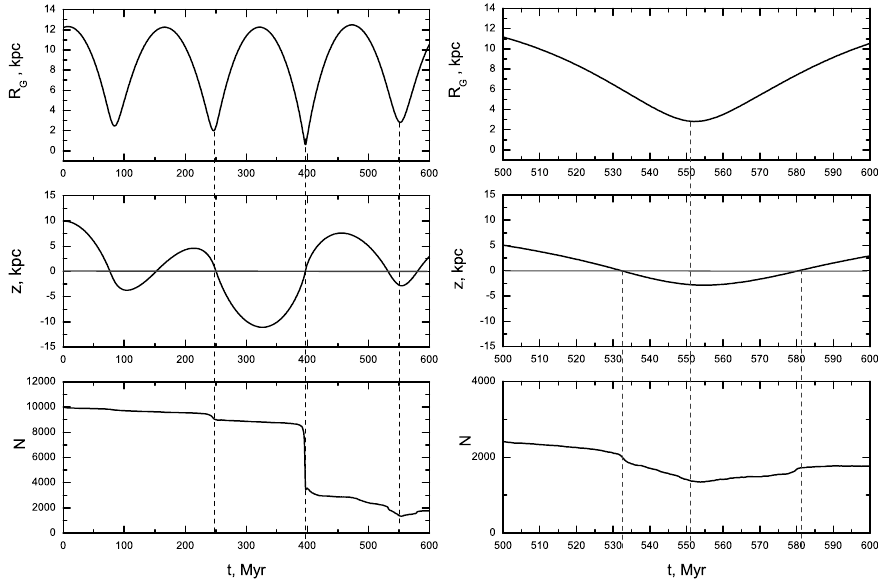
Fig. 3. Time-dependence of the number of stars in a GC, its position above the plane of the disk and the distance to the Galactic center (bottom to up); time interval in the range 500(cid:21)600 Myr is zoomed on the right-hand